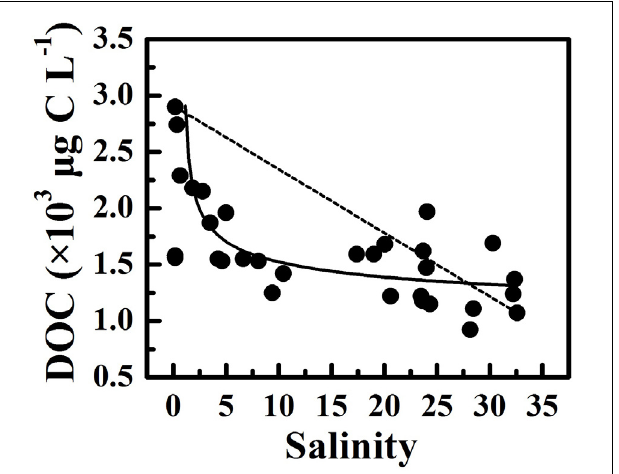
FIGURE 6 | The variability of DOC concentration along salinity gradient during our cruises. The dashed line links the DOC concentration at the lowest and the highest salinity, and the solid line denotes the relationship between DOC concentration and salinity.